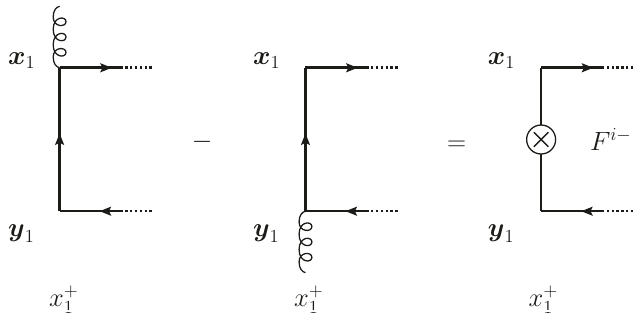
Figure 4 . Diagrammatic representation of eq.